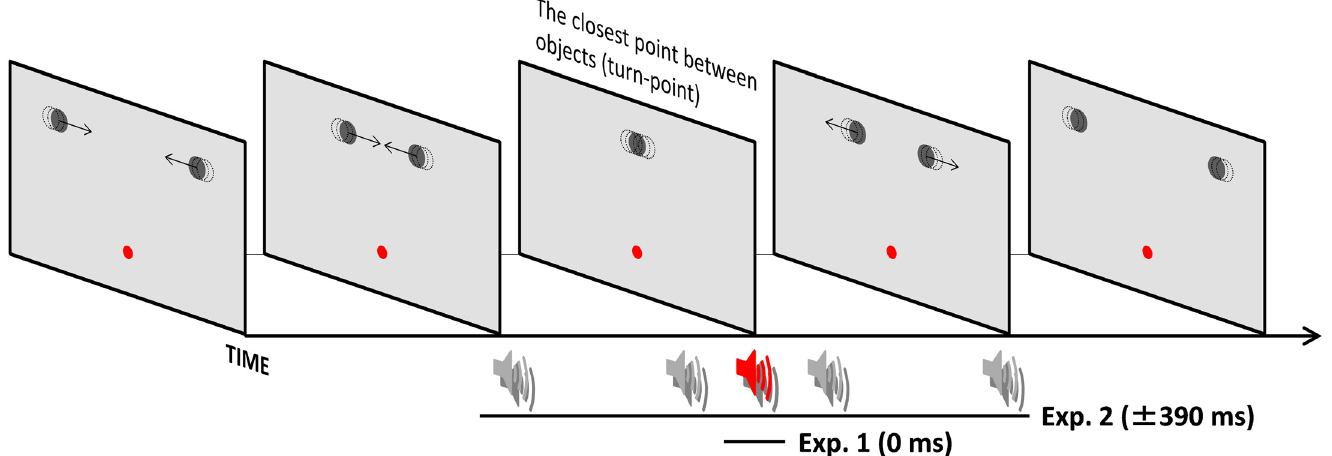
Fig 1. Schematic illustration of stimuli for Experiment 1. The objects moved from opposite sides toward each other. After 630 ms of motion, objects started to reverse their direction with some degree of overlap and returned to their original positions. The starting points for either object (dashed-line circle) were displaced to manipulate the distance between the object centers, that is, the degree of object overlap in a trial-by-trial